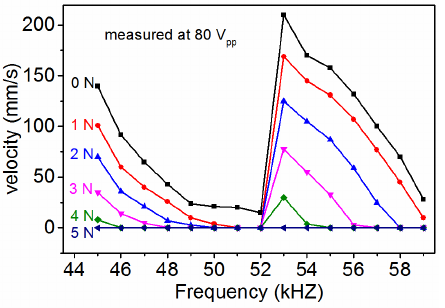
Figure 11. Velocity vs. frequency characteristics at different loads.